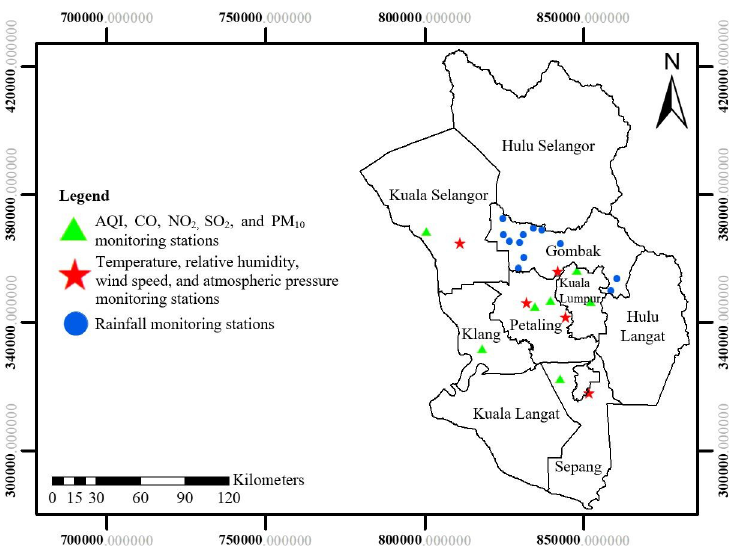
Fig 2. Spatial distribution maps of environmental monitoring stations in Selangor and Kuala